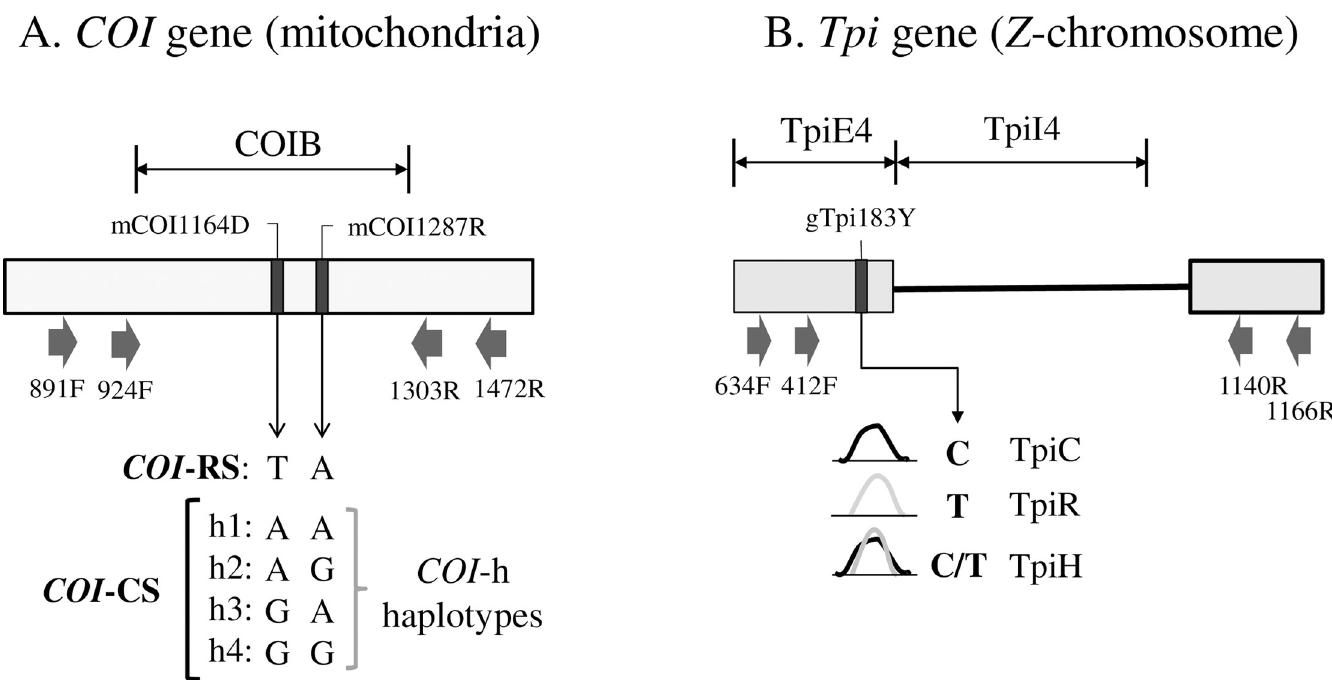
Fig 2. Diagrams of the segments from the COI and Tpi genes used for the genetic analysis. A: COIB gene segment identifying PCR primers used to amplify the fragment (block arrows) and the strain and COI-h haplotype defining the mCOI1164D and mCOI1287R polymorphic sites. CO1 -RS is defined as a T and A at mCOI1164D and mCOI1287R, respectively. There are four corn-strain ( CO1 -CS) haplotypes (h1-h4) with and A or G observed at both mCOI1164D and mCOI1287R. B: Portion of the fall armyworm Tpi gene with block arrows indicating PCR primers. The TpiE4 exon segment contains the gTpi183 site that is polymorphic for a C or T. Representative DNA chromatograph patterns are shown to illustrate how TpiC, TpiR, and TpiH are defined. The TpiI4 intron segment lies adjacent.